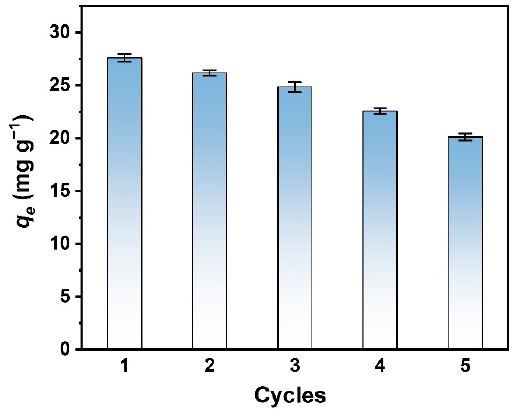
Figure 7. q e of FeSA-MgBC-3 at different cycles.